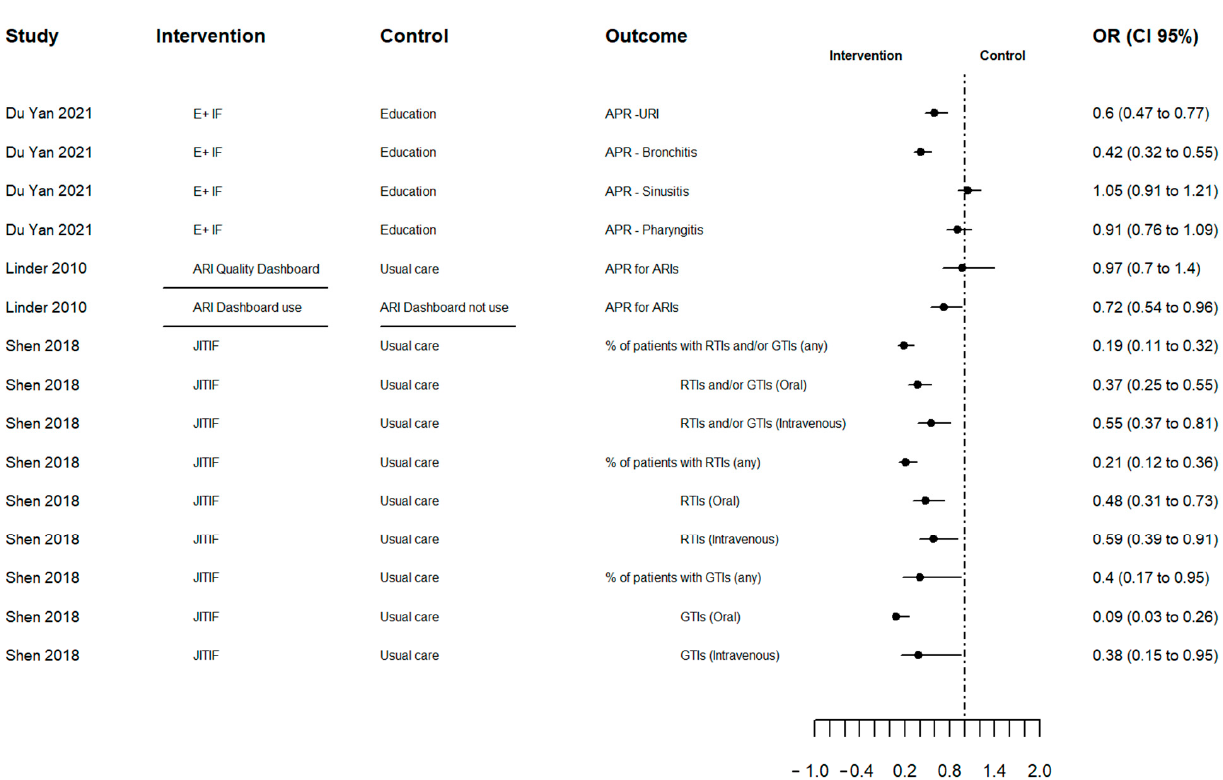
Figure 2. Forest plot of antibiotic prescribing change outcome in odd ratios. Source: elaborated by the authors with information reported of studies included. E+F: Education plus individualized prescribing feedback dashboard; ARI: Acute Respiratory Infection; ARI Quality Dashboard Use (line segment): intervention physicians who used the ARI Quality Dashboard at least once versus intervention clinicians who did not use it; JITIF: Just-in-Time Information and Feedback; APR: Antibiotic prescription rate; URI: Upper respiratory infection; RTIs: Respiratory tract infections; GTIs: Gastrointestinal tract infections; OR: Odd ratio; CI: confidence interval.